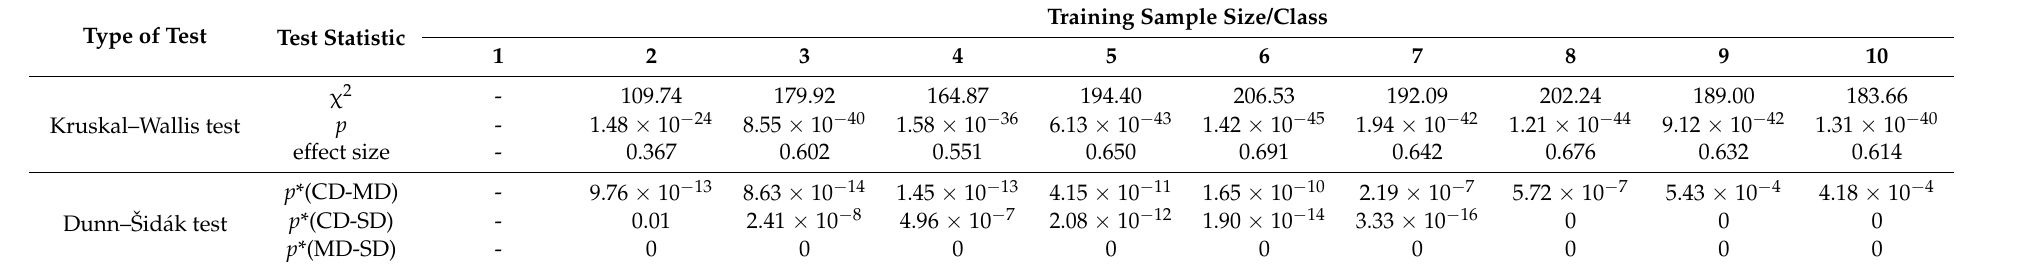
Table A4. Results of Kruskal–Wallis test and Dunn–Šidak post hoc test for LDA algorithm ( α = 0.05).